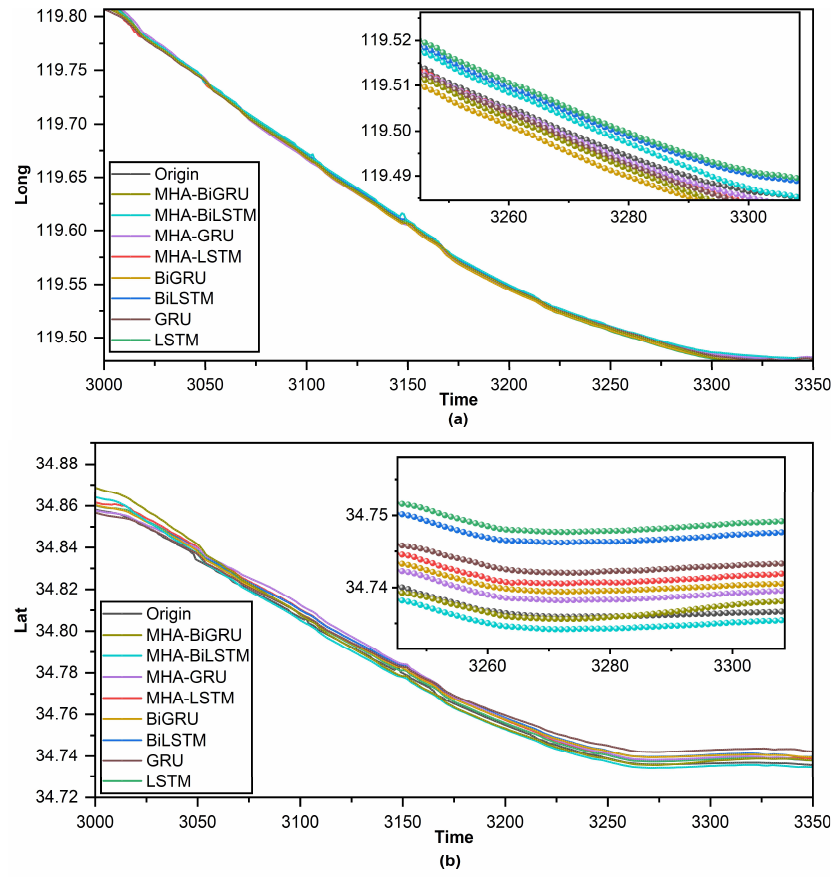
Figure 8. Loss value of overall comparative experiments.